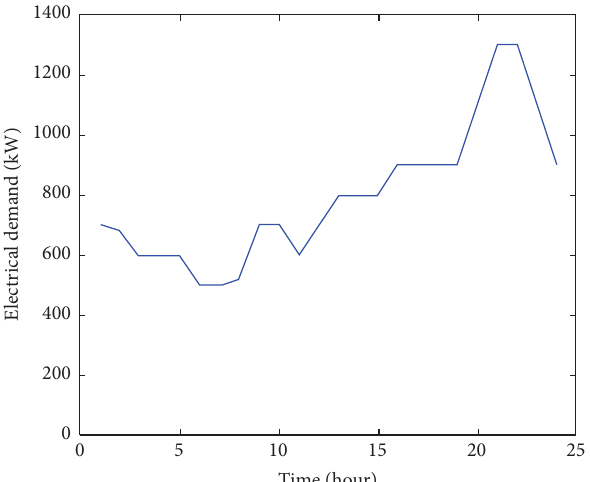
Figure 5: Water demand of the energy hub system.